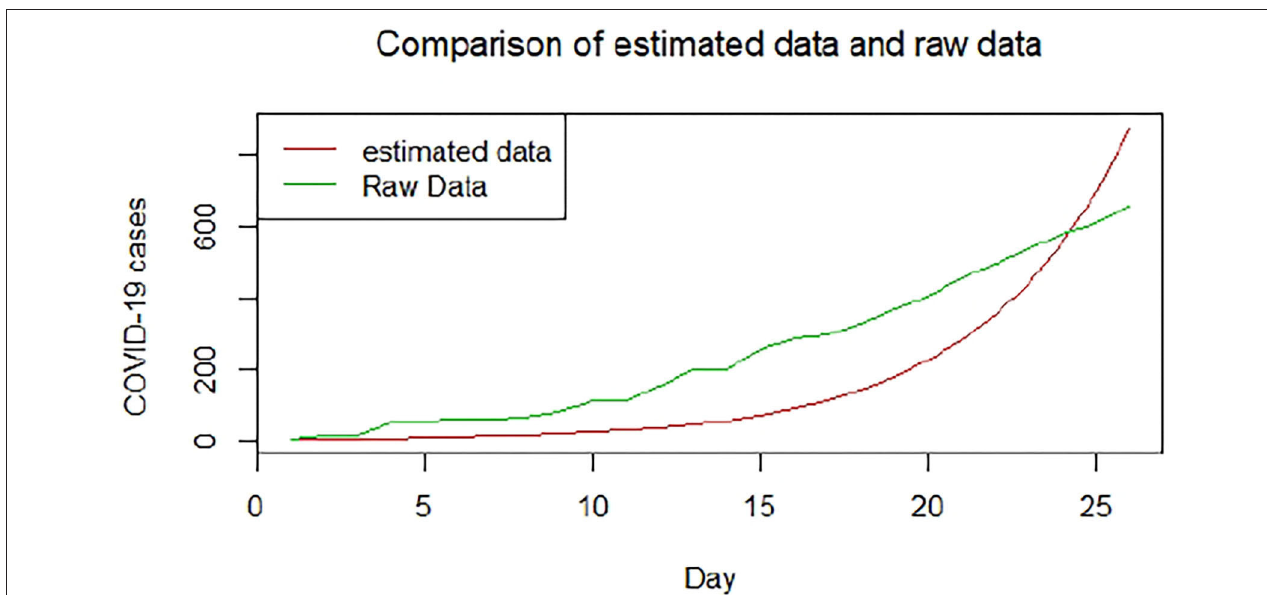
FIGURE 21 | Graph for Egypt.